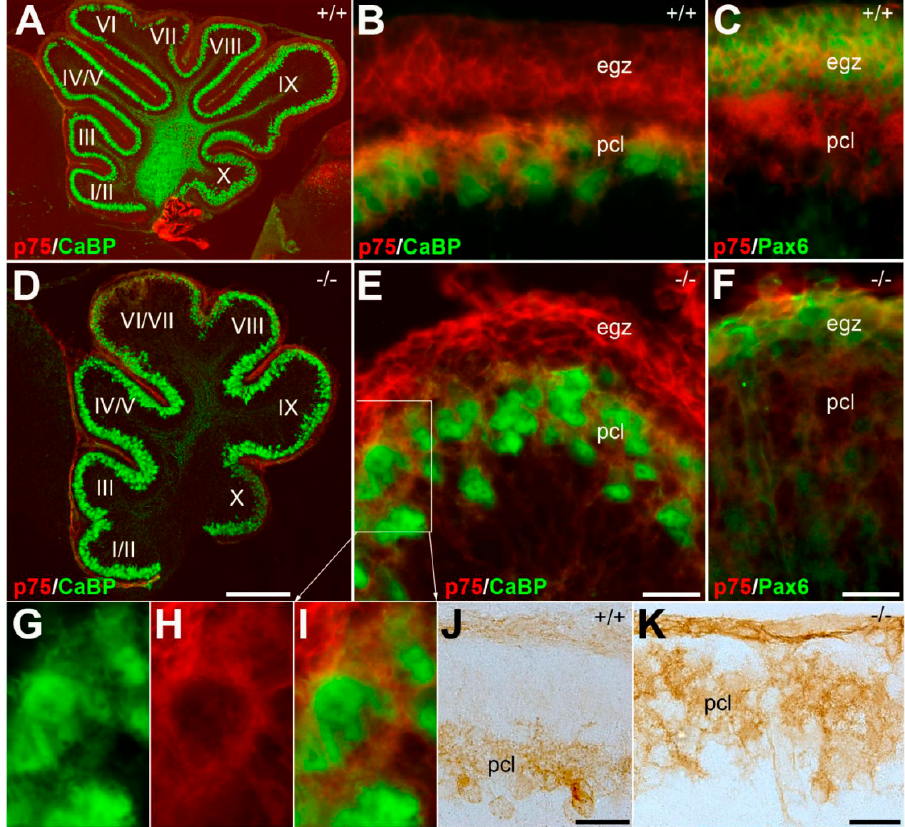
Figure 2. Sagittal sections of P4 wt +/+ ( A – C ) and nax − / − ( D – I ) and sagittal sections of P6 wt ( J ) and nax ( K ) cerebella immunostained with p75NTR, CaBP and Pax6. The lobules are shown by